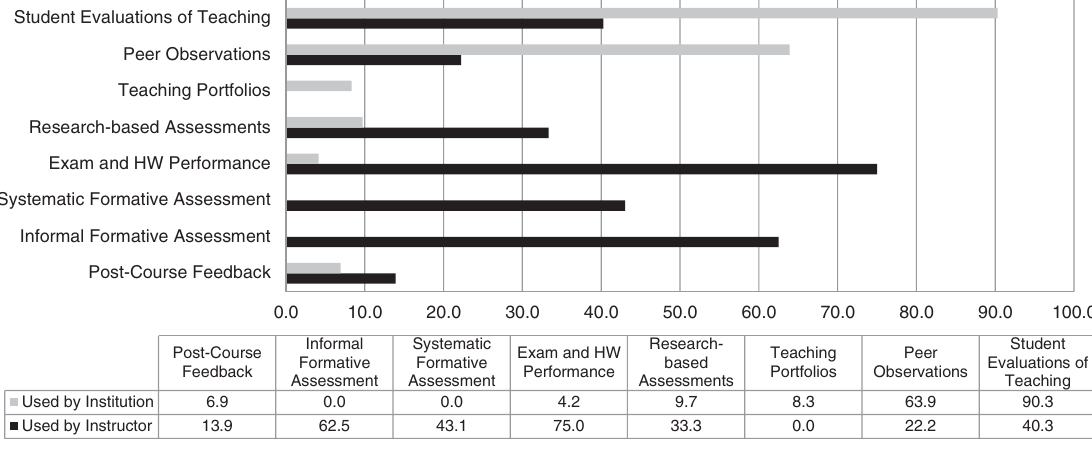
FIG. 2. Reported use of various sources of assessment information by instructor and by institutions in judging teaching